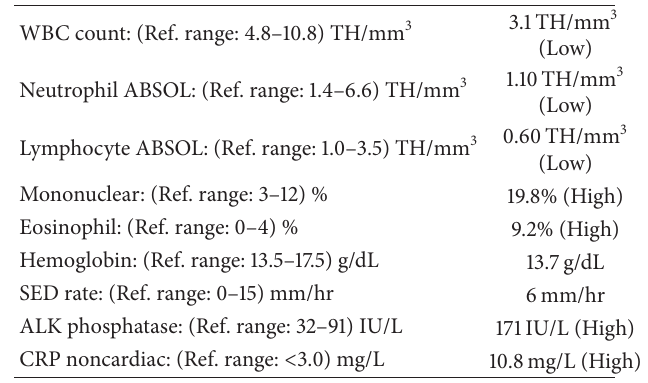
Table 1: Patient’s serology laboratory values.